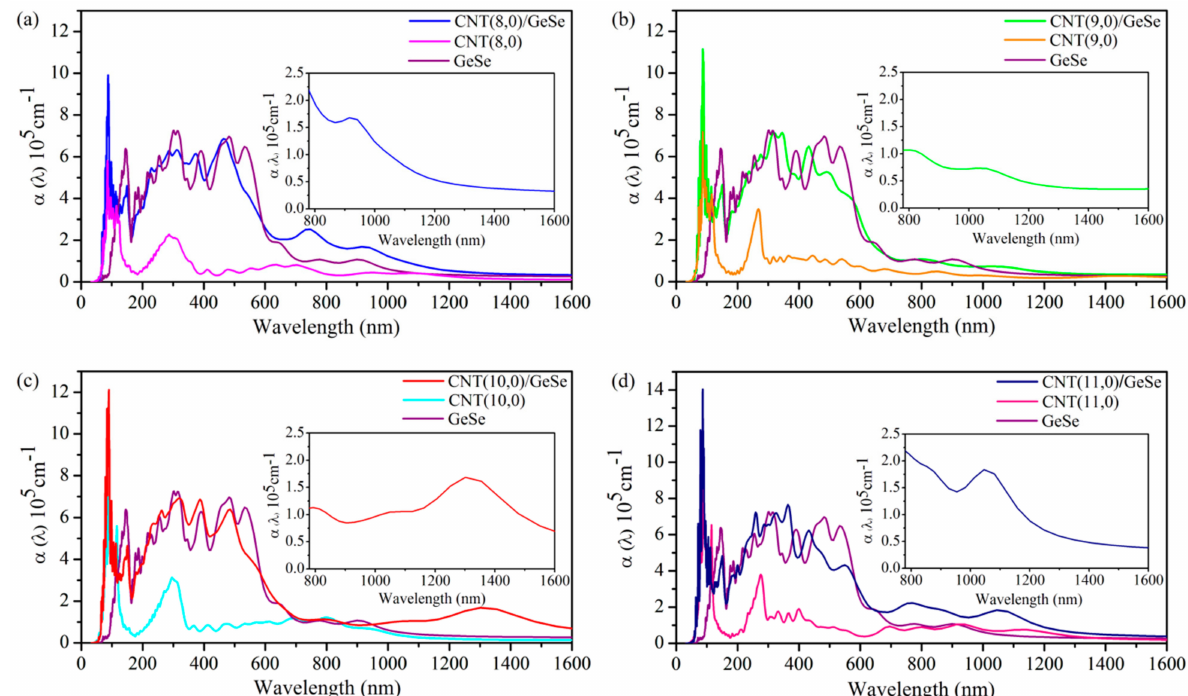
Figure 7. Optical absorption coefficient, α , of ( a ) (8,0)CNT/GeSe, monolayer GeSe, and (8,0)CNT; ( b ) (9,0)CNT/GeSe, monolayer GeSe, and (9,0)CNT; ( c ) (10,0)CNT/GeSe, monolayer GeSe, and (10,0) CNT; and ( d ) (11,0)CNT/GeSe, monolayer GeSe, and (11,0)CNT at the zigzag